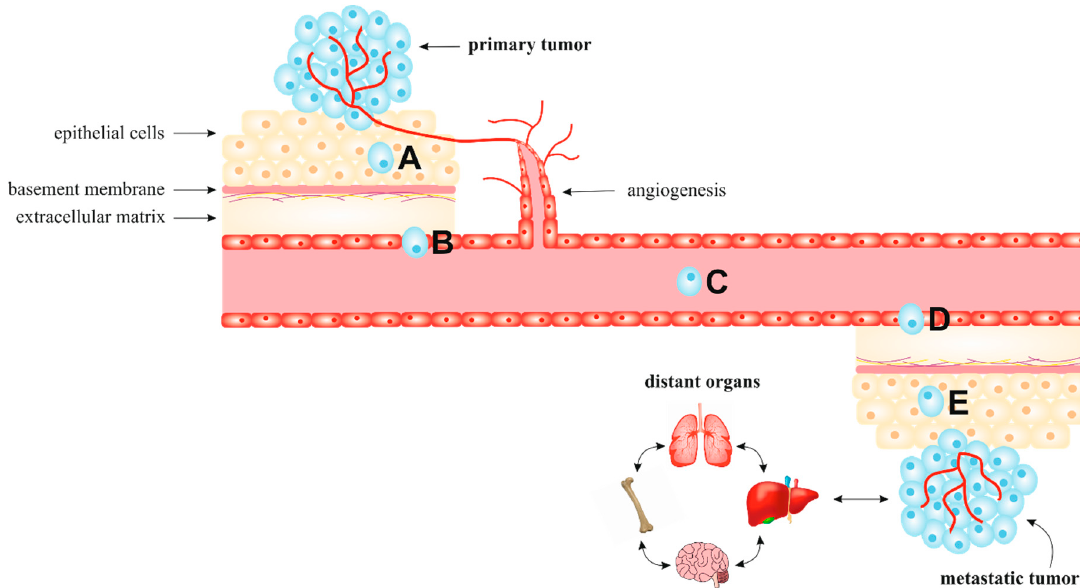
Figure 1. The individual steps of metastasis: local invasion (A), intravasation (B), circulation in blood or lymphatic vessels (C), extravasation (D), and colonization and metastasis (E). Cancer cells from a primary tumor can infiltrate surrounding parenchyma and pass through the blood vessel’s membrane to circulate. The survival rate of circulating tumor cells (CTC) is around 0.2%. Therefore, only a small proportion extravasate and metastasize to target organs as disseminated tumor cells (DTC) [29]. The resulting micrometastatic mass enlarges and colonizes the target organ [30]. Metastatic lesions are primarily detected in specific organ sites (liver, lung, bone, brain) but rarely in others (kidney, heart, stomach) [7].